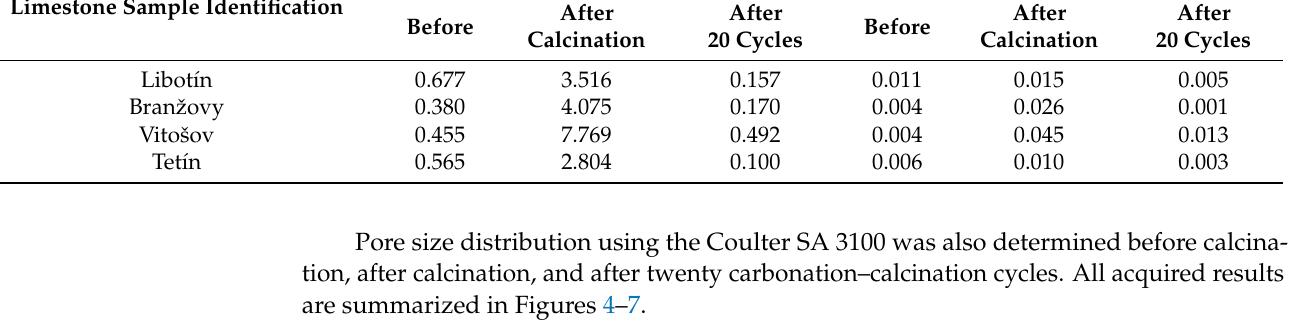
Table 2. Comparison of specific surface area and pore volume.